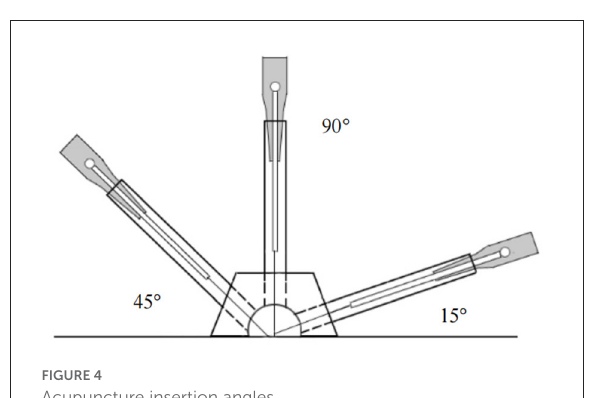
FIGURE4 Acupuncture insertion